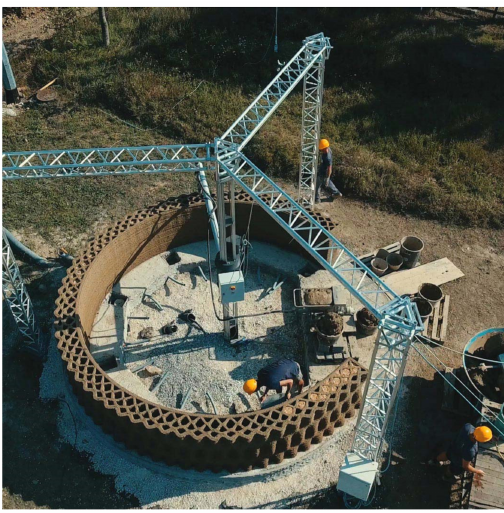
Figure 9. WASP 3D printer with insulation inside printed walls [10]. Reprinted with permission from Ref. [10]. 2018,